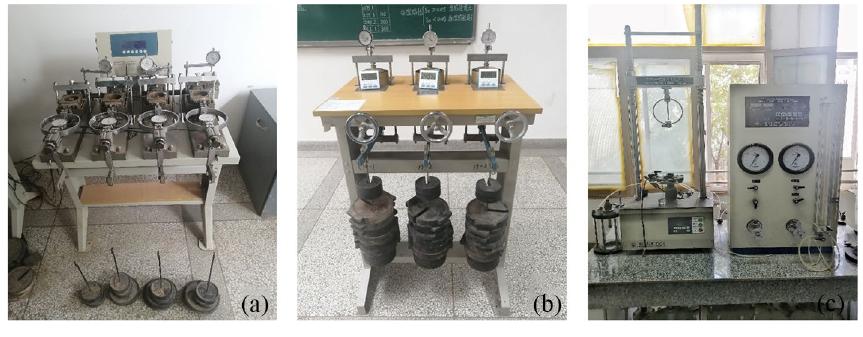
Figure 3. Testing equipment.